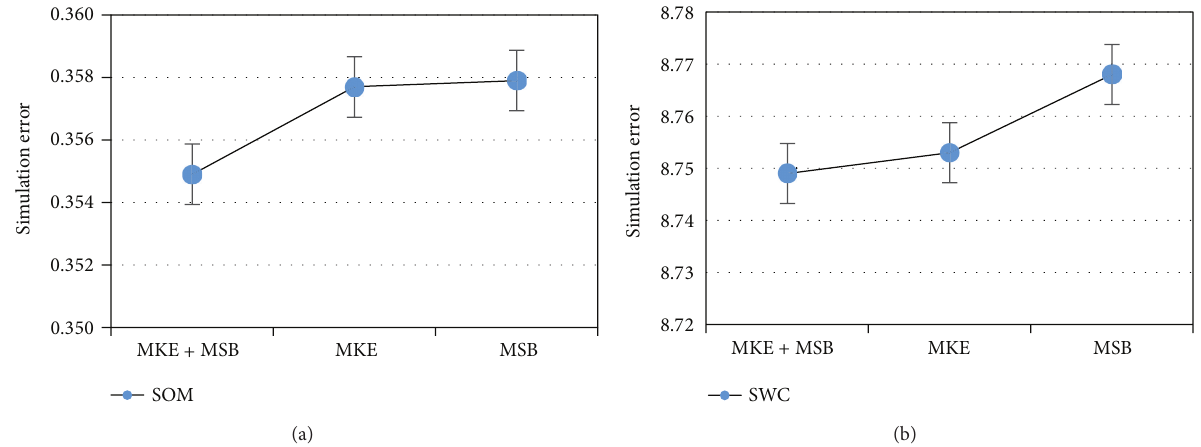
Figure 5: Simulation errors (SE) of two optimal monitoring networks for SOM and SWC. For each soil variable, SE was averaged over 150 realization of the superpopulation based on the known variograms of two soil variables and a sequential Gaussian simulation method.